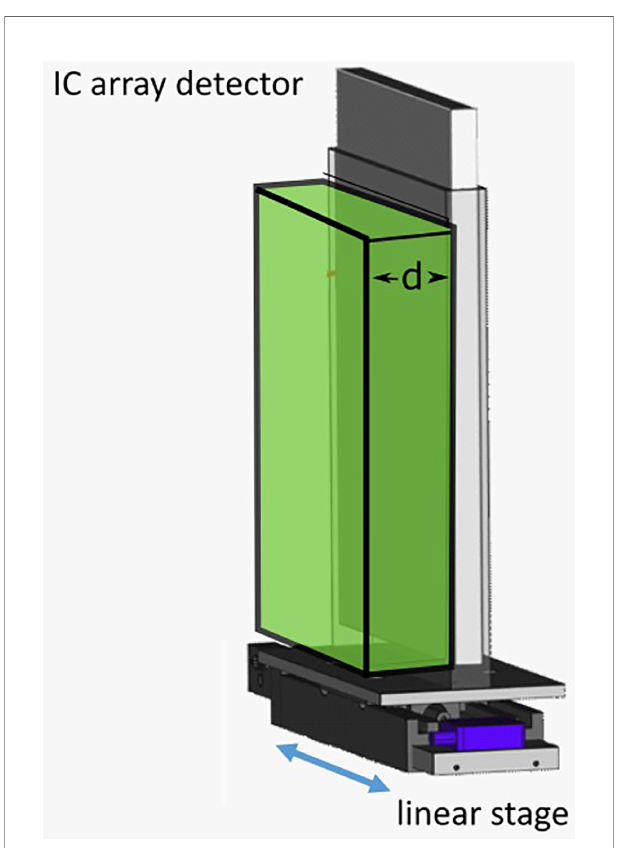
FIGURE 2 | Schematic of the ionization chambers (IC) detector array setup. The IC array detector is placed inside of a 5 mm polymethylmethacrylate (PMMA) holder, mounted onto a linear stage. Water-equivalent plastic of thickness “ d, ” corresponding to the distal, middle or proximal depths of a target, are then placed in front of the